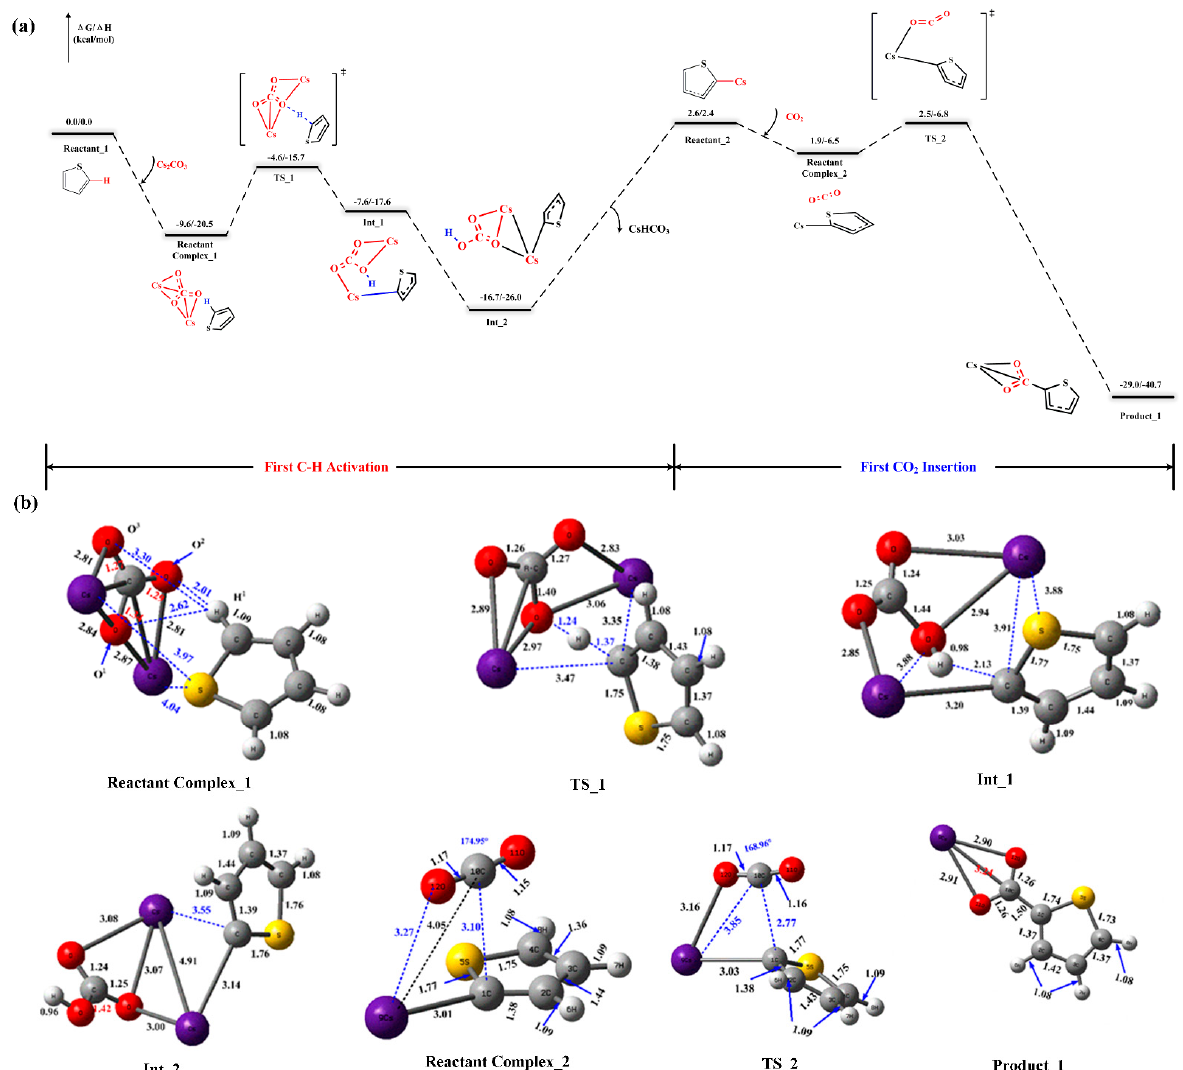
Figure 1. ( a ) Reaction energy profiles of the first carboxylation reaction. Energies are relative to the reactants of Reactant_1 and Cs 2 CO 3 . ( b ) All reported structures and their important geometric parameters (distances are in Angstroms (Å)).